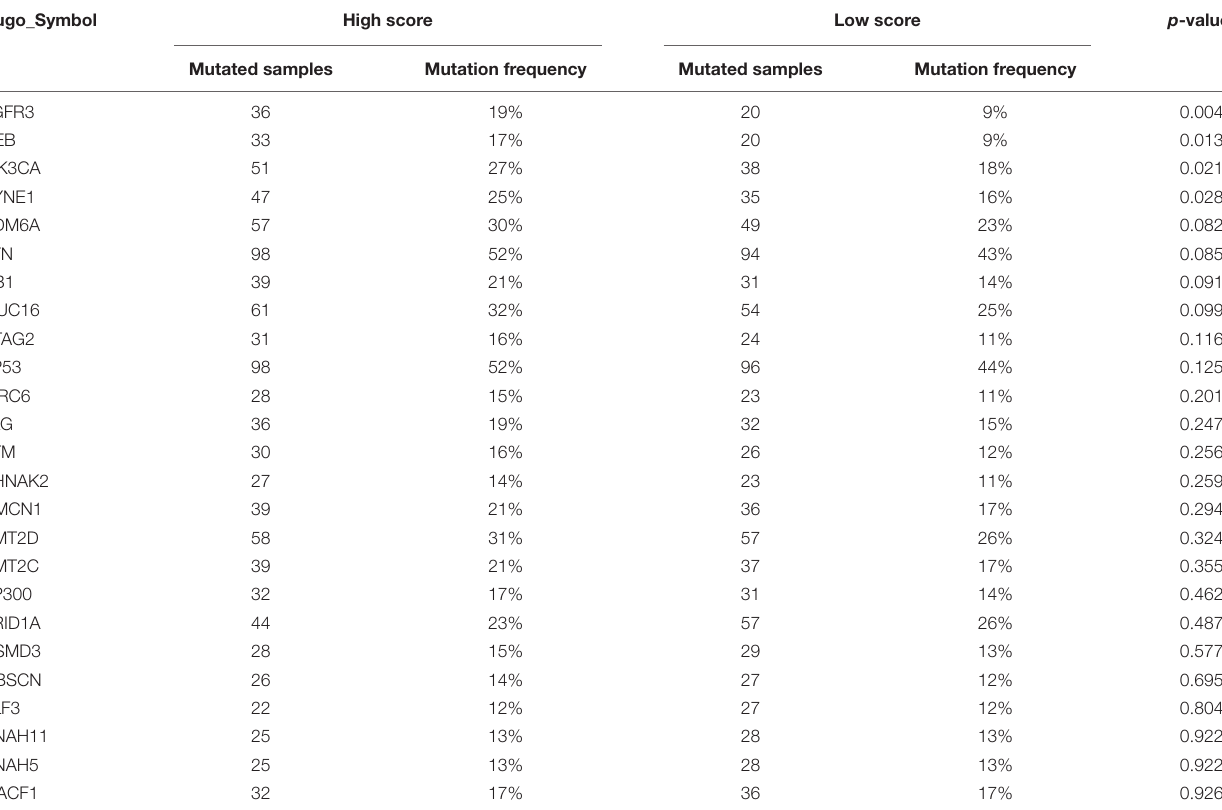
TABLE 1 | The association between ICI score and somatic variants. Hugo_Symbol High score Low score p